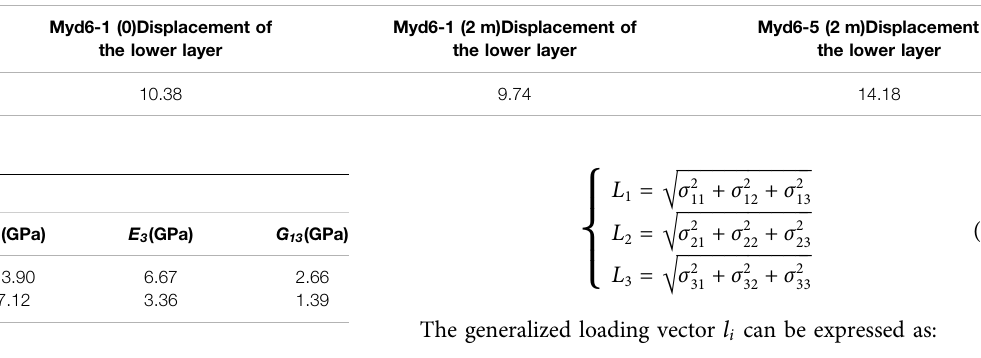
TABLE 3 | Invert the target value.